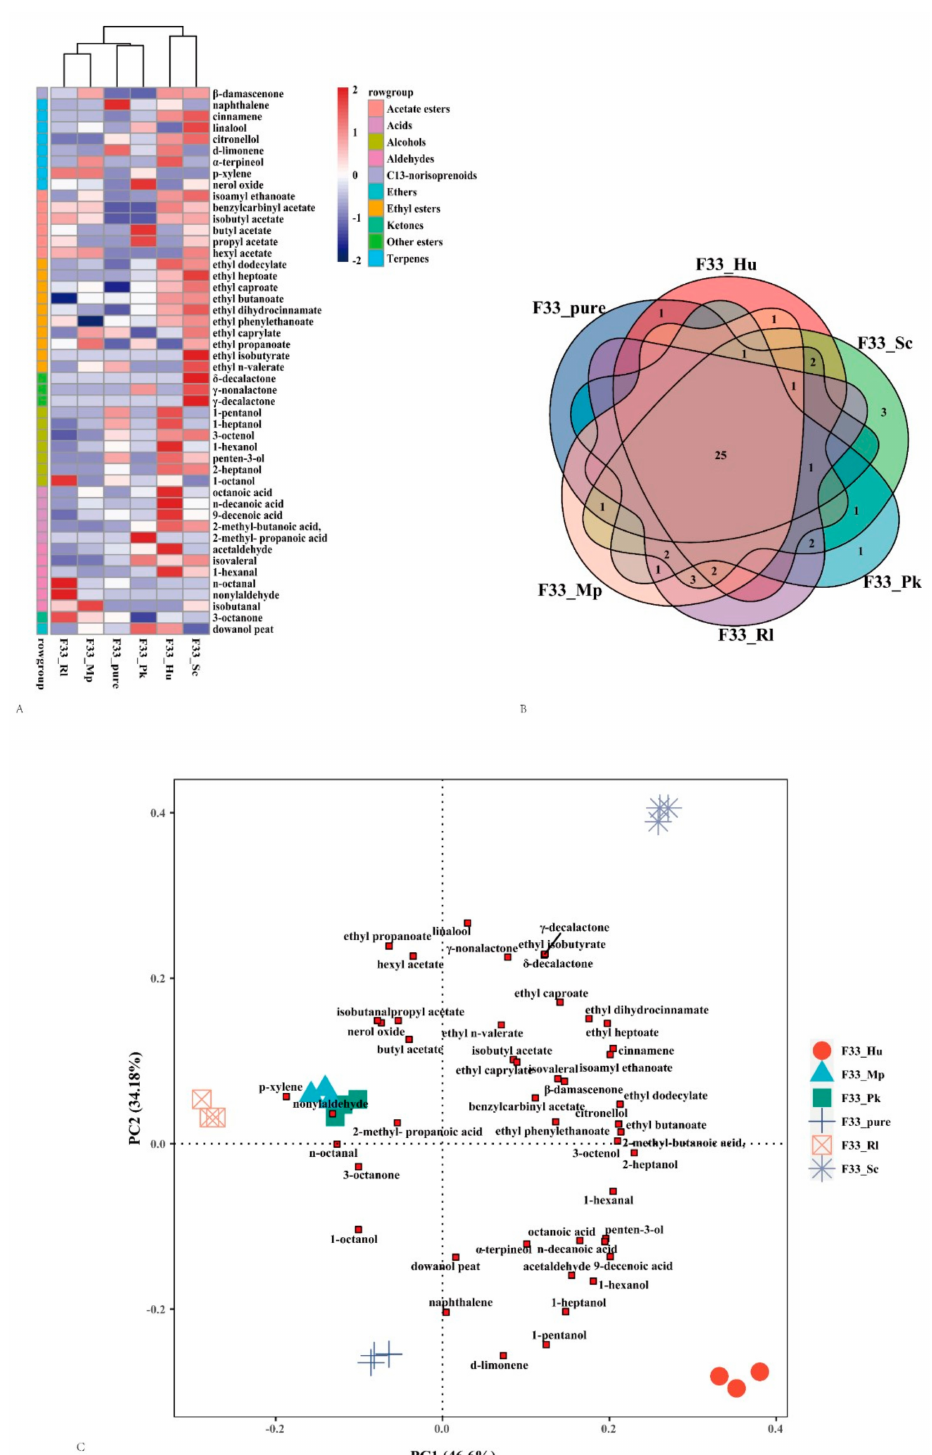
Figure 6. Aroma-active compounds from Vidal icewine fermented with six fermentation strategies. pure_F33: S. cerevisiae F33 monoculture. F33_Hu: co-inoculation of S. cerevisiae F33 and H. uvarum QTX22. F33_Sc: co-inoculation of S. cerevisiae F33 and S. crataegensis Y30. F33_Mp: co-inoculation of S. cerevisiae F33 and M. pulcherrima YC15. F33_Pk: co-inoculation of S. cerevisiae F33 and P. kluyveri HSP11. F33_Rl: co-inoculation of S. cerevisiae F33 and R. lusitaniae QTX26. ( A ) Pheatmap clustering graph of aroma-active compounds. Red: relatively high production; blue: relatively low production. Count represents the standardized content aroma-active compounds. ( B ) Venn diagrams of the aroma-active compounds. ( C ) Principal component analysis of aroma-active